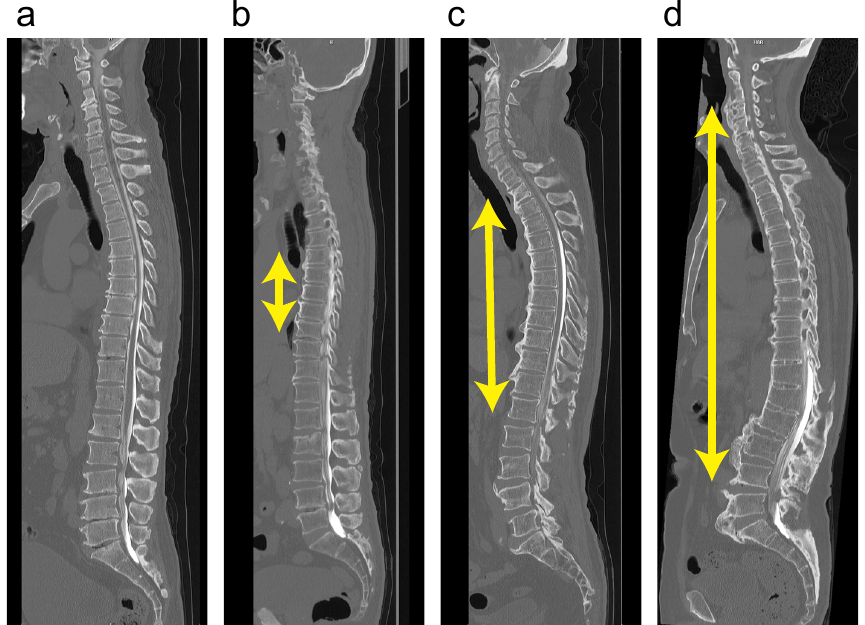
Figure 1. Representative sagittal computed tomography image for DISH grades 0–3. ( a ) Grade 0 (no DISH); ( b ) Grade 1 (DISH at T3–T10); ( c ) Grade 2 (DISH at both T3–T10 and C6–T2 and/or T11–L2); ( d ) Grade 3 (DISH extending beyond C5 and/or L3). DISH, diffuse idiopathic skeletal hyperostosis.